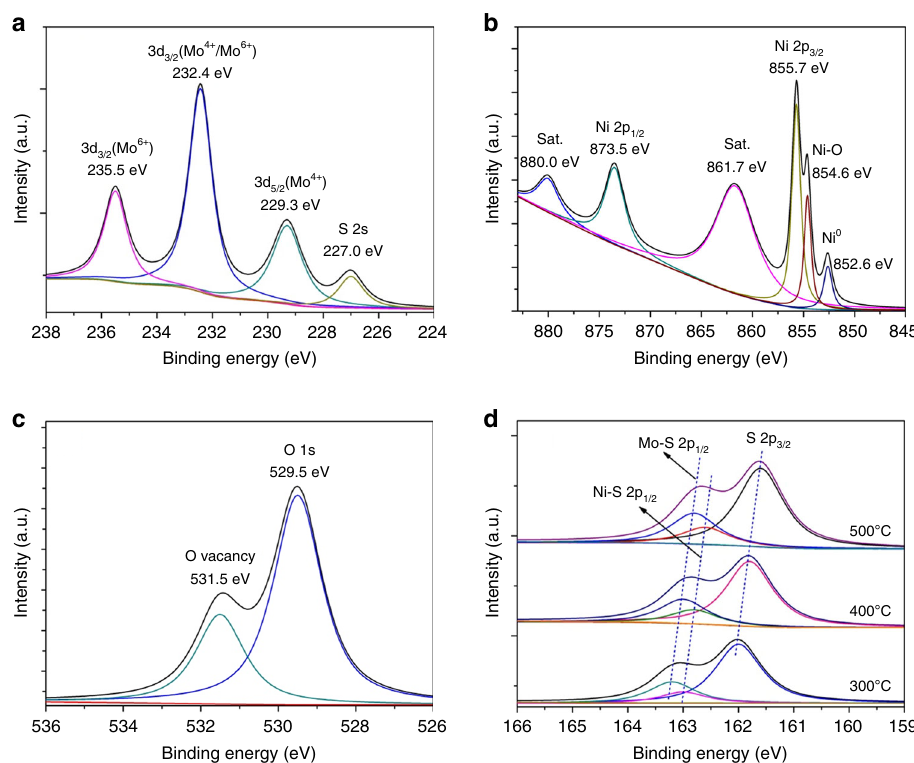
Fig. 4 XPS spectra of NiMoO x /NiMoS. High-resolution XPS signals of a Mo 3 d , b Ni 2 p , c O 1s, d S 2 p of NiMoO x /NiMoS array with different thermal treatment temperatures.